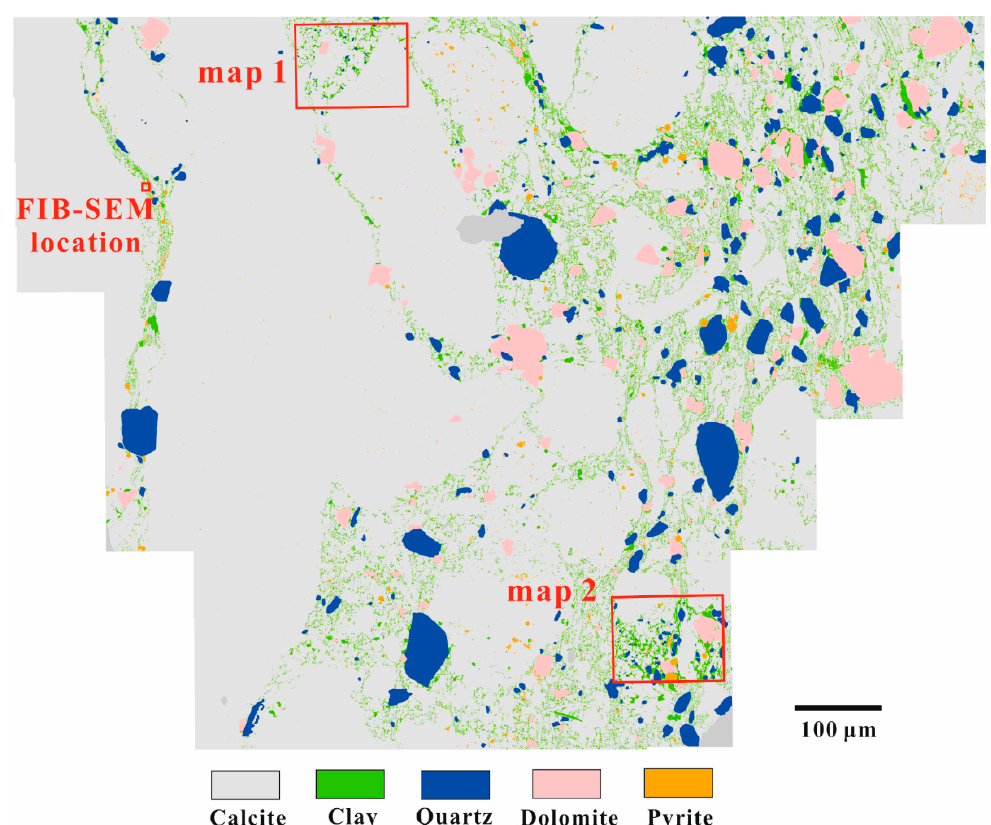
Figure 5. Mineral distribution overview of BIB-polished Cobourg limestone surface (0.72 mm 2 ). The red squares show the areas of BIB-SEM maps 1 and 2 and the location for FIB-SEM.